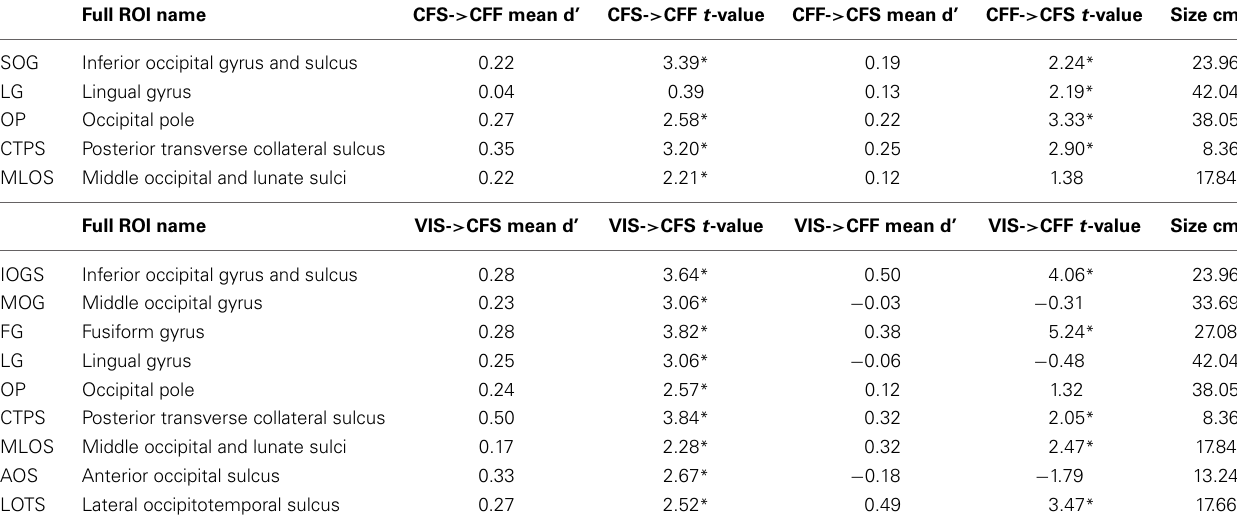
Table 2 | Names and t-values for all ROIs where at least one of the between-method classifications was